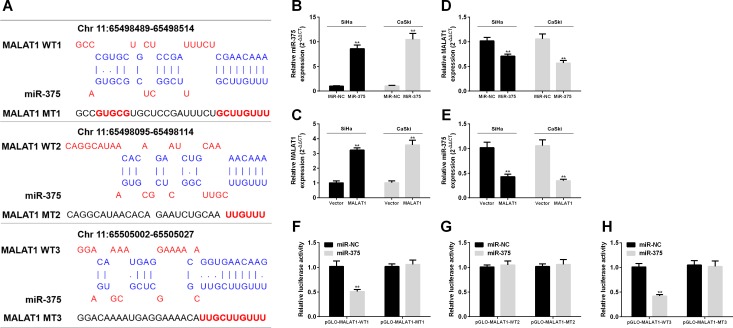
There is a reciprocal regulation between miR-375 and MALAT1 in cervical cancer cells.A. Predicted three binding sites between MALAT1 and miR-375. WT: wild type sequence; MT: the designed mutant sequence without binding sites. B and D. QRT-PCR analysis of miR-375 (B) and MALAT1 (D) expression in SiHa and CaSki cells after transfection of miR-375 mimics. C and E. QRT-PCR analysis of MALAT1 (C) and miR-375 (E) expression in SiHa and CaSki cells after infected with MALAT1 expression lentiviral particles. F-H. Dual luciferase assay of the inhibiting effect of miR-375 mimics on Renilla luciferase expression in Hela cells co-transfected with pmirGLO-MALAT1-WT1 or pmirGLO-MALAT1-MT1 (F), pmirGLO-MALAT1-WT2 or pmirGLO-MALAT1-MT2 (G), pmirGLO-MALAT1-WT3 or pmirGLO-MALAT1-MT3, ** p<0.01.